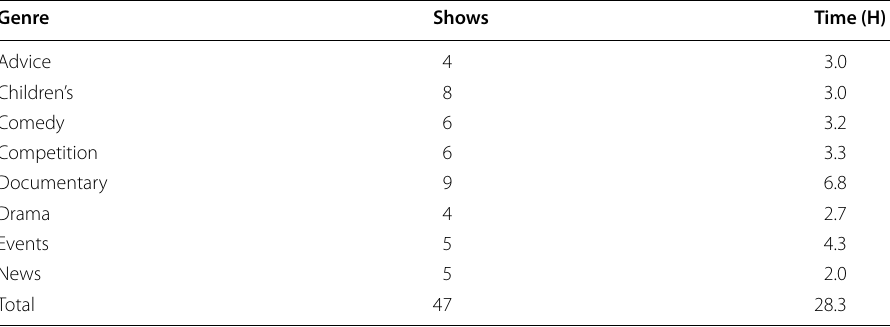
Table 1 The distribution of the data in terms of shows and broadcast time Genre